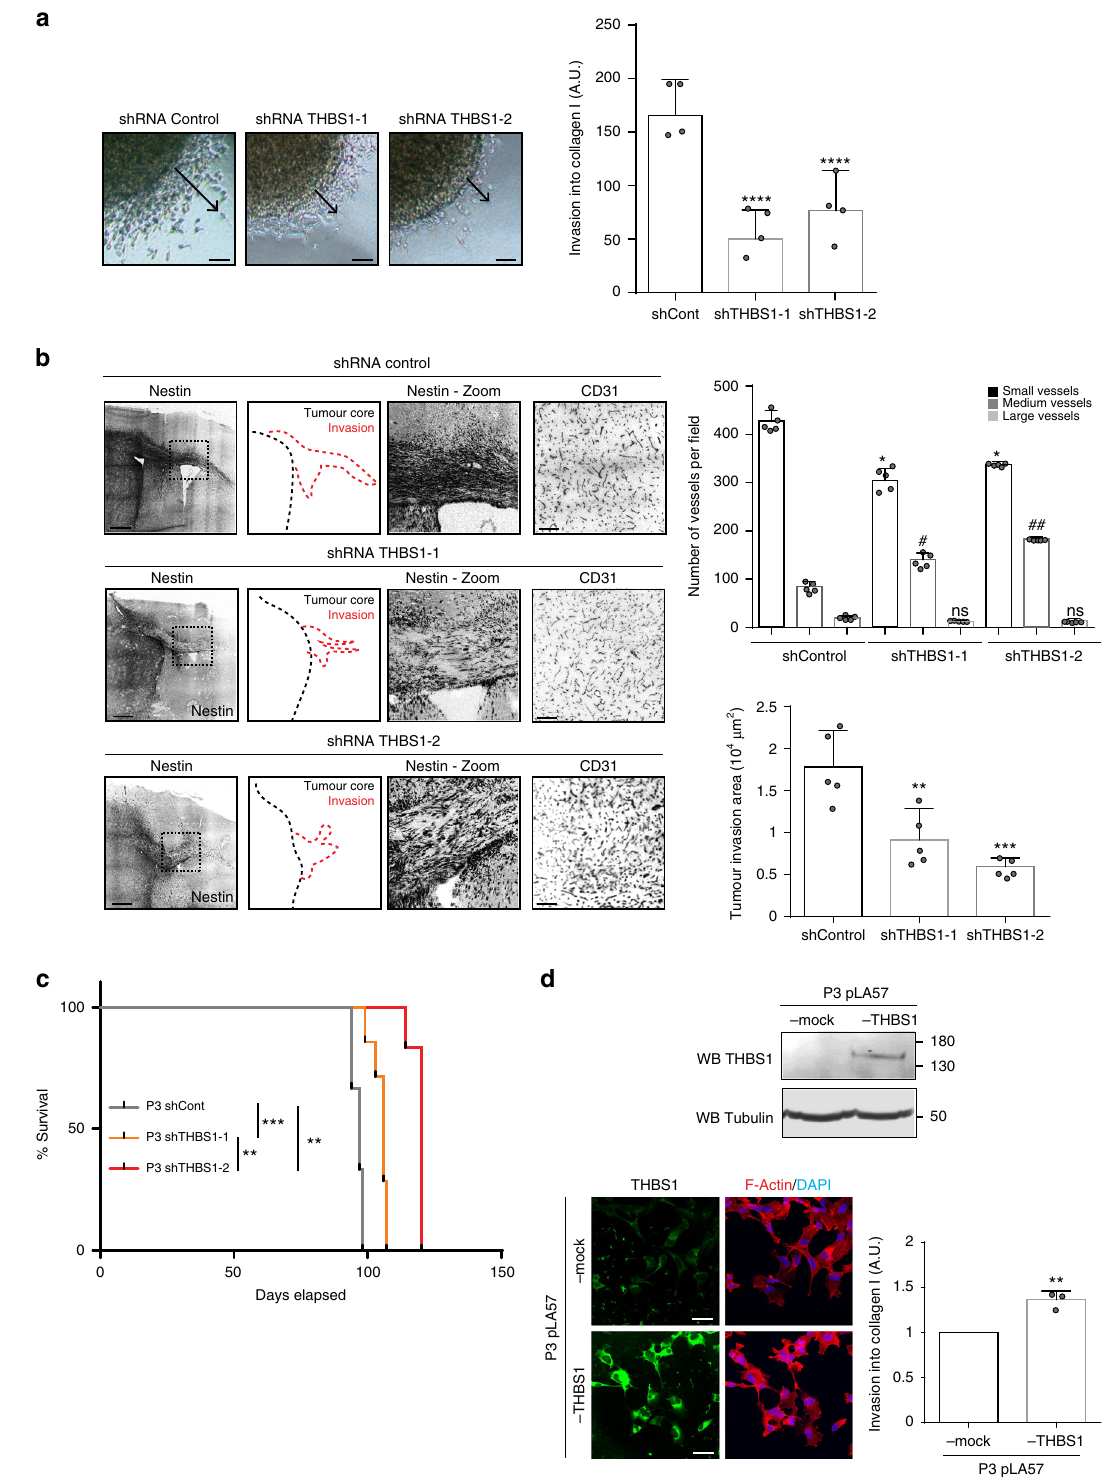
THBS1 is the gene with highest connectivity . To reinforce our results at a global scale, we performed transcriptomics analysis via RNA-sequencing of P3 tumours. GFP-labelled tumour cells from both invasive and angiogenic areas of P3 were visualised and then laser-microdissected prior to RNA isolation and sequencing (Fig. 1c). Gene expression pro fi ling and data analysis were per- formed with respect to human and mouse RNA independently using Xenome (Supplementary Data 1). Principle